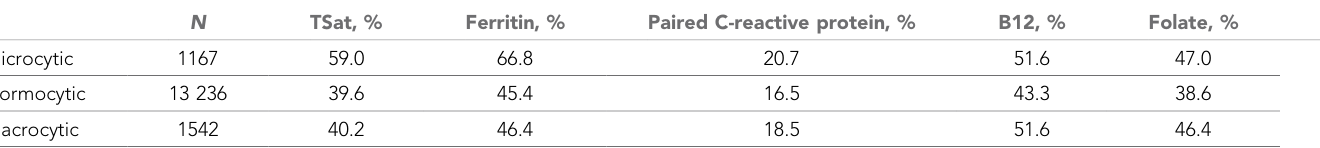
Table 3 Percentage of patients